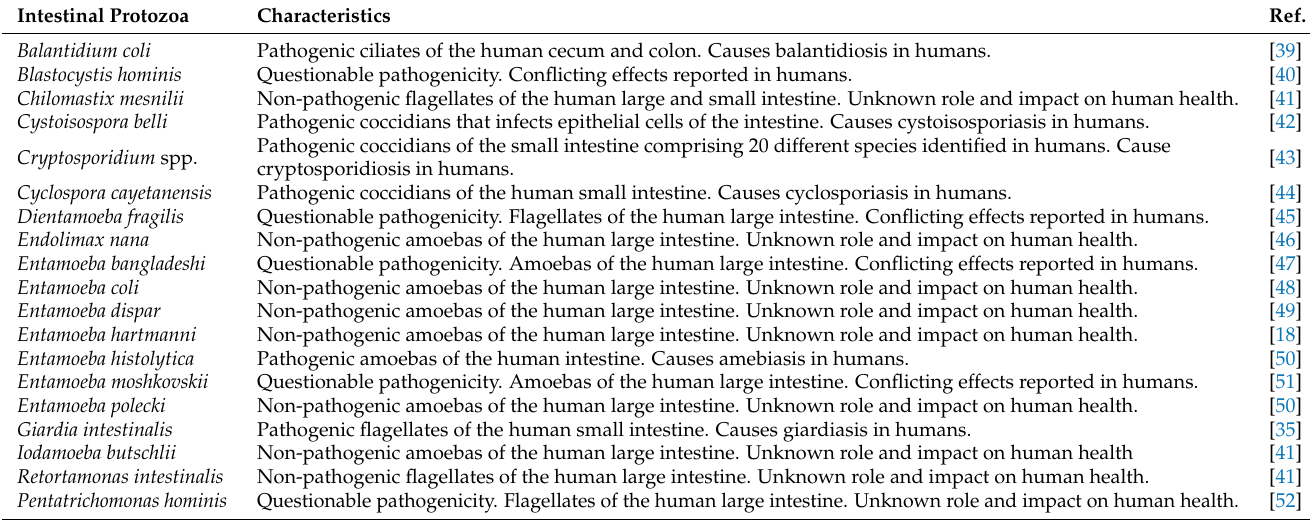
Table 1. Human intestinal protozoa species and their